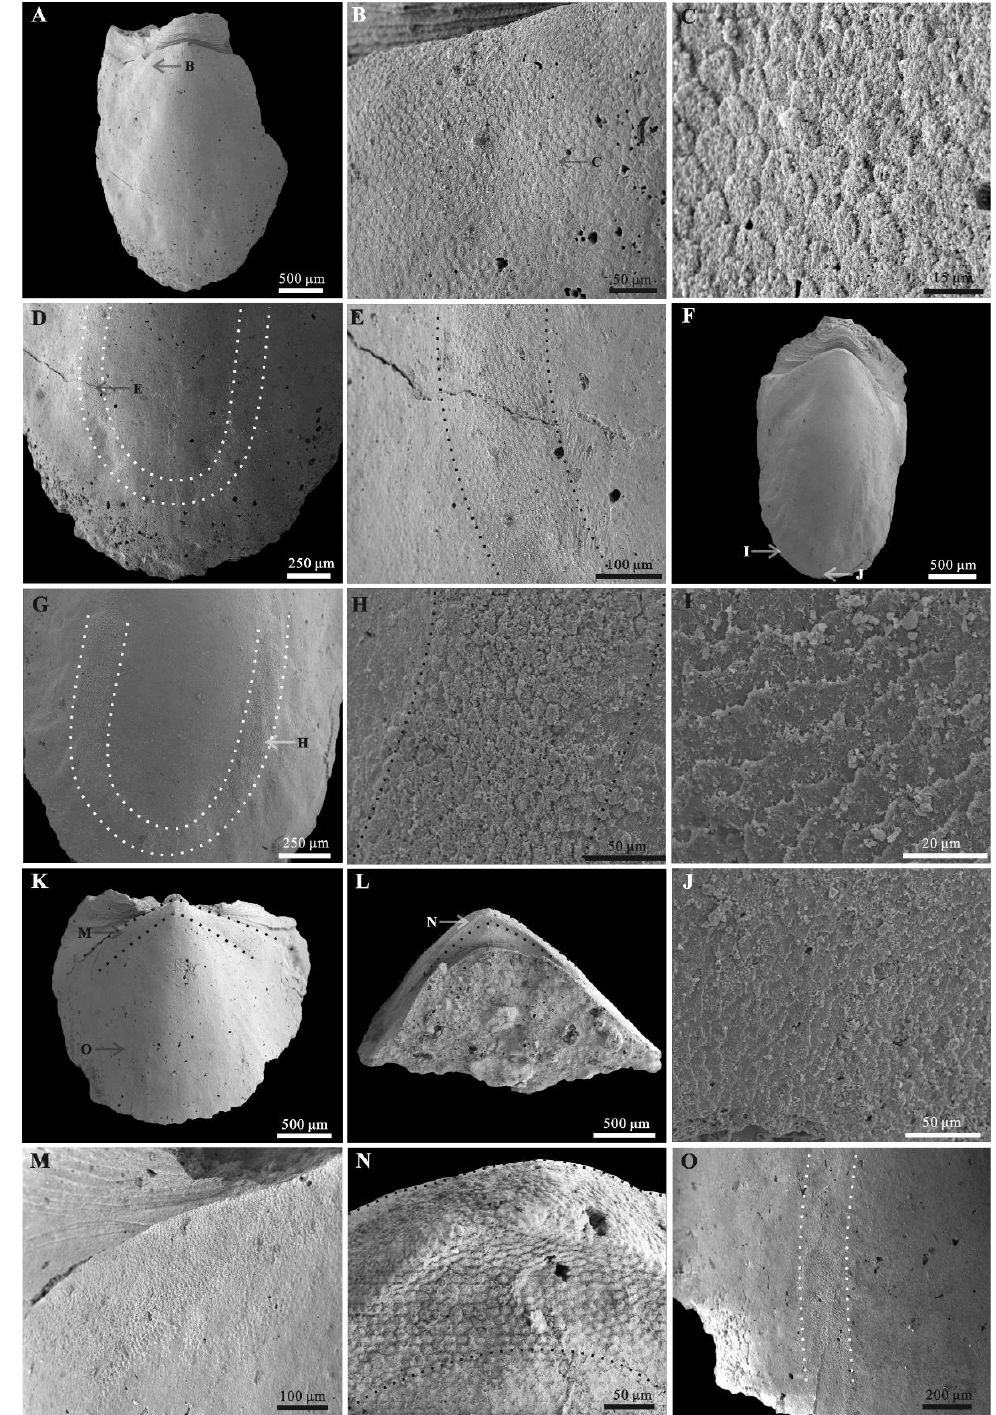
Figure 6. Muscle attachment zones and stepwise texture on Eohalobia sclerites. ( A – E ), ( F – J ), ( K – O ) Internal molds, CUBar121–2, CUBar132–3, CUBar227–6, respectively. ( A – K , J , M , O ) Dorsal view, ( L , N ) proximal view. ( B , M , N ) Magnification of ( A , K , L ), respectively, showing the distribution of muscle attachment zone in high-arched apical field sloping toward lateral margins. ( C ) Magnification of ( B ), showing the shape and size of convex polygonal texture. ( D , G , O ) Magnification of ( A , F , K ), respectively, showing the U-shaped muscle attachment zone symmetrically arranged on both sides of the middle surface near the lateral margins and interface between the muscle scar region and the rest of shell interior. ( I , J ) Magnification of ( F ), showing the stepwise texture occurred in the posterior and lateral margin. Arrows show the position of enlarged areas. Dotted lines zones show the distributions of muscle attachment